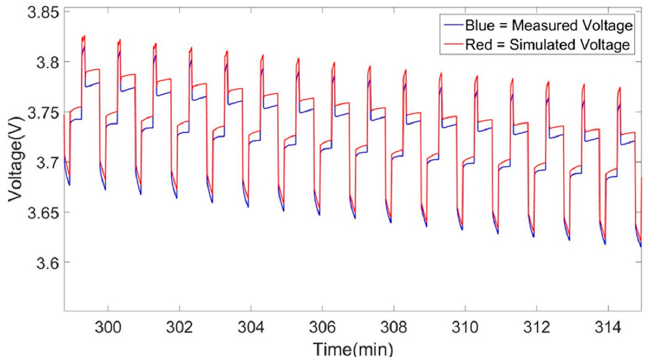
Figure 11. Error of the 1st order Thévenin model measured and simulated DDP comparison at 25 °C with Coulomb counting and normal characterization. Energies 2016 , 9 , 360 12 of 23